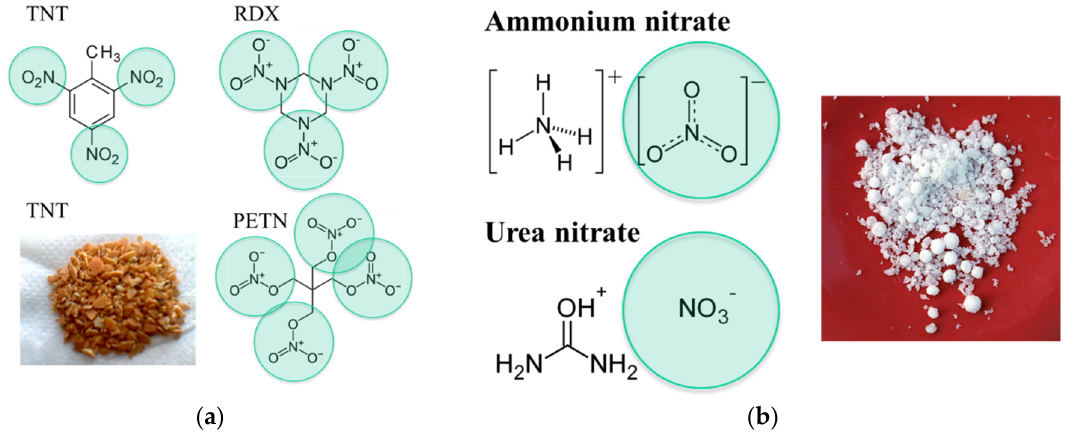
Figure 2. Molecular structure of explosives: ( a ) military high explosives; ( b ) improvised explosives. All substances contain strongly electron ‐ attracting NO x side groups (marked by green circles.